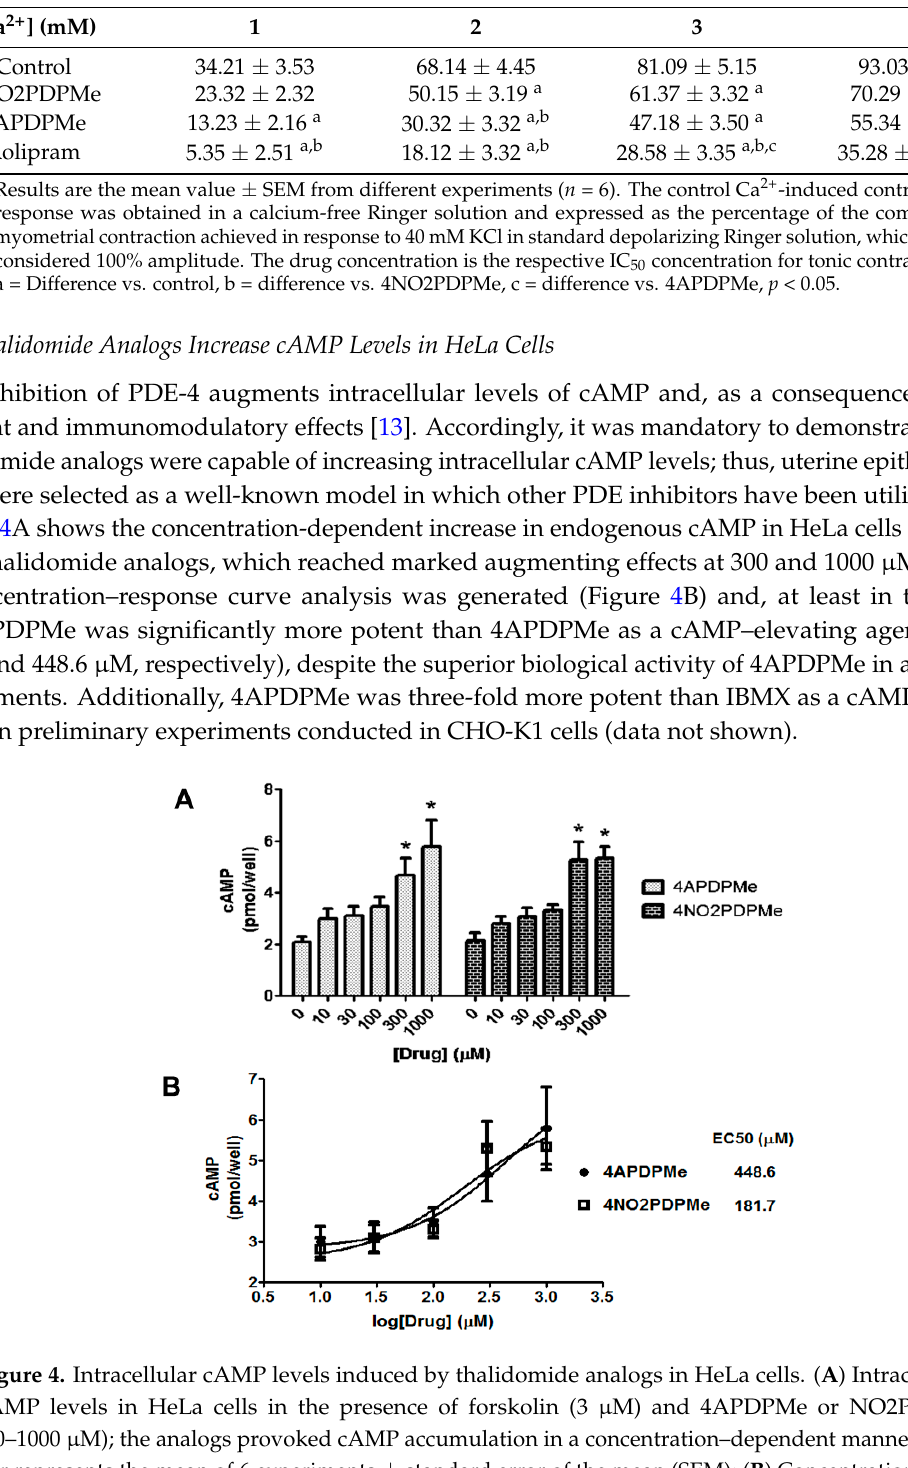
Table 2. Comparative analysis of Ca 2+ -induced contractile responses in the presence of rolipram and thalidomide analogs.